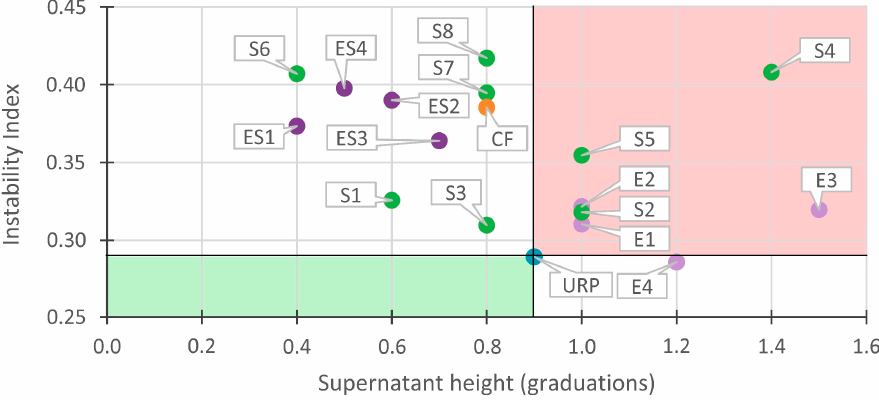
Figure 10. Correlation between the instability index and supernatant height in URP with 0.2% of dispersing agents. Refer to Tables 1–4 for dispersing agent labels. Green area = positive impact on stability, red area = negative impact on stability.